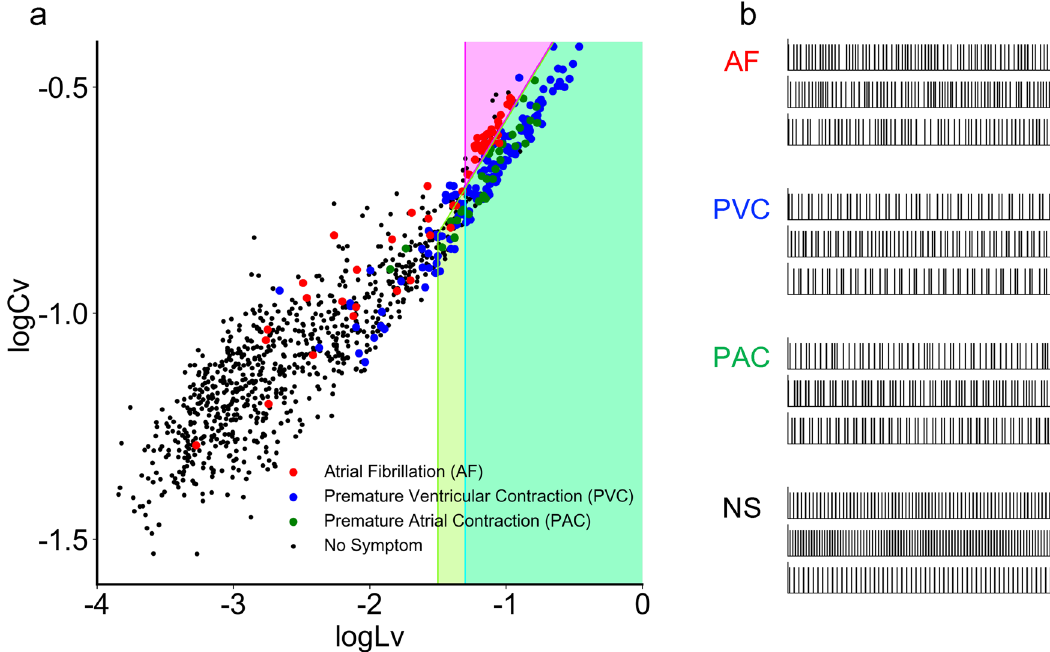
Figure 3. Different cardiac disorders plotted on a plane spanned by the new and old metrics log 10 Lv and log Cv . ( a ) Dots represent 1,017 subjects, who were diagnosed as atrial fibrillation (AF), premature ventricular 10 contraction (PVC), premature atrial contraction (PAC), and negative, respectively colored in magenta, blue, and green, and black. The prediction zone for each cardiac disorders, given by the set of constraints log 10 Lv > a and log Lg log Lv 2 log Cv > b ( or < b ) is depicted by the appropriate colors. ( b ) Representative pulse 10 10 10 = − sequences of 1 minute, respectively taken from four different cases. NS stands for no Figure 3a displays the distribution of datapoints representing subjects with different cardiac diseases plotted on a plane spanned by log 10 Lv and log 10 Cv . The distribution seemingly comprises different groups; there is 3 and low log Cv 1.2 , while the datasets with one big cluster at the lower left, centered at low log 10 Lv 10 ≈ − ≈ − 2 tended to align linearly with the slope in parallel to log Lv 2log Cv . higher log 10 Lv > 10 10 − − Measurements associated with cardiac disorders are located in the upper right region defined by high values of log Lv and log Cv . On further analysis, the data points representing different cardiac disorders are distributed 10 10 differently in this region; fibrillation (AF) cases are located on the upper side, whereas premature contraction (PVC and PAC) cases are located on the lower side. Representative pulse sequences of 1 minute taken from these diagnostic cases are depicted in Fig. 3b. To determine how the local variation Lv and the coefficient of (global) variation Cv contribute to the separa- tion of premature contractions and fibrillation, we newly introduce a metric of the local-global variation ratio ( Lg ), defined as Lv Lg . = Cv 2